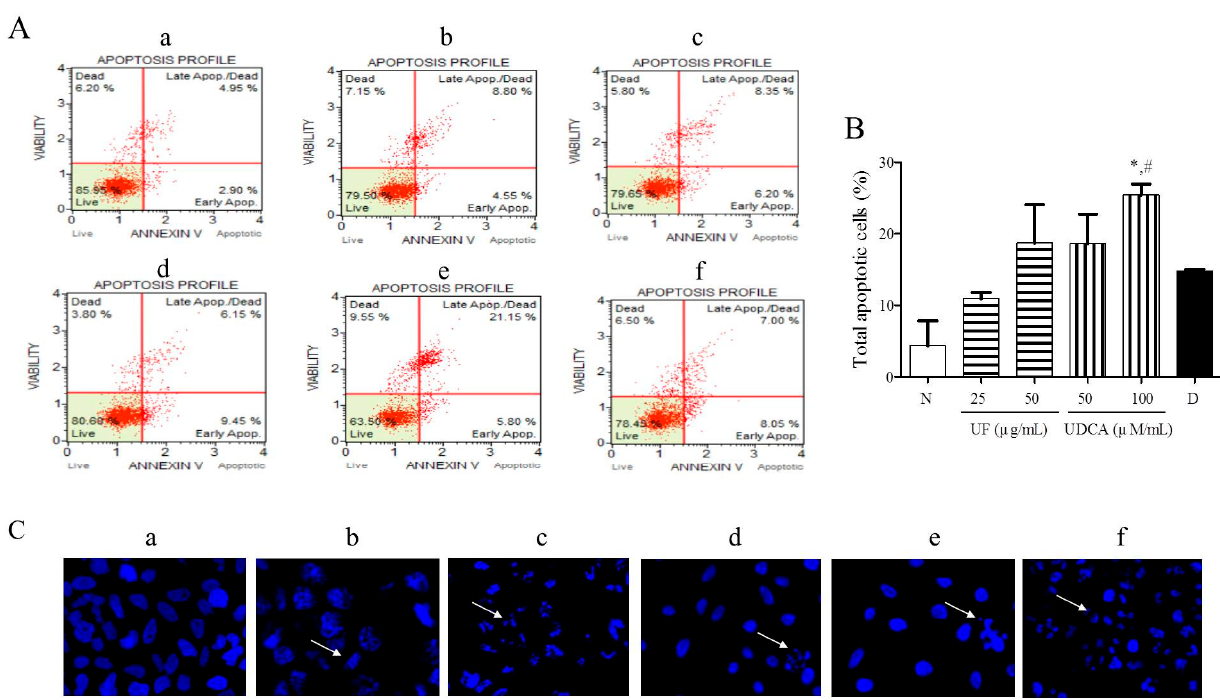
Figure 2. Effects of UF extract and UDCA on the apoptosis of human FRO anaplastic thyroid cancer cells. The cells were treated with UF or UDCA at indicated concentrations for 48 h: ( A ) Cell apoptosis was measured by flow cytometric analysis following Annexin V/PI staining. ( B ) Apoptotic ratios were calculated as the number of apoptotic cells per total number of cells. The data represent one of three independent experiments. p < 0.05 vs. normal cells (*) or docetaxel-treated cells (#). ( a ) Untreated cells; ( b ) 25 µ g UF-treated cells; ( c ) 50 µ g UF-treated cells; ( d ) 50 µ M UDCA-treated cells; ( e ) 100 µ M UDCA-treated cells; and ( f ) 2 nM docetaxel-treated cells. ( C ) Nuclear fragmentation was observed by Hoechst staining using a fluorescence microscope ( × 400). Arrows show apoptotic cells with nuclear